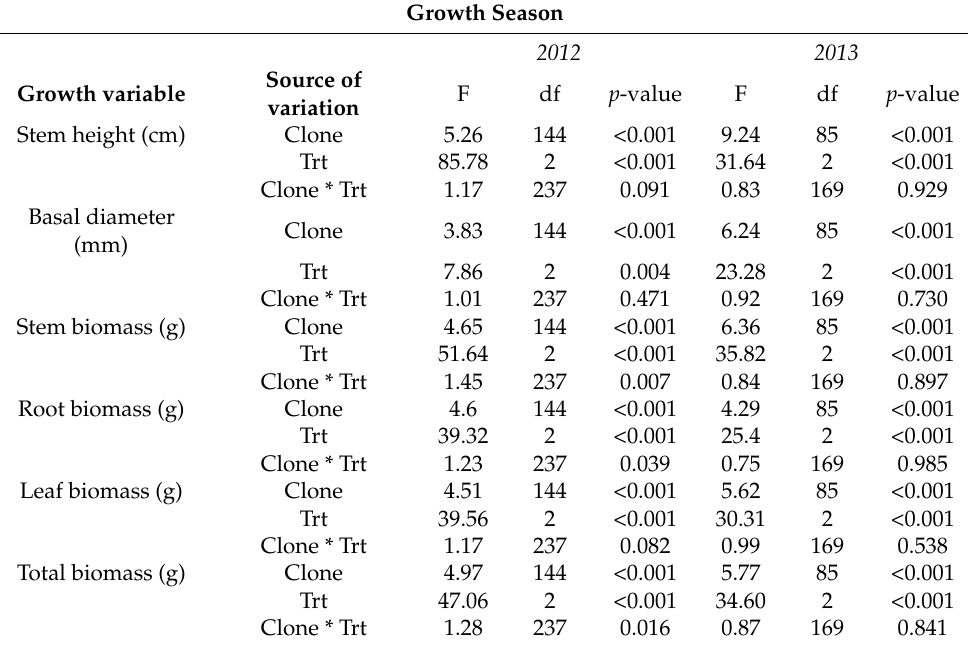
Table A3. Growth variables of balsam poplar tested by ANOVA indicating the source of variation, F-value, degrees of freedom (df), and p -value for the 2012 and 2013 greenhouse experiments for different clones, treatments, and interaction effects. Trt = treatment.